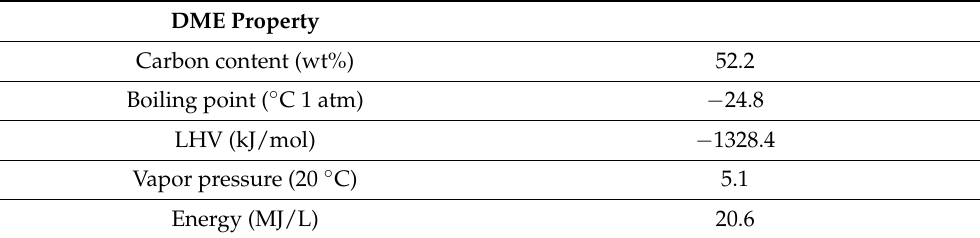
Table 1. Physicochemical properties of dimethyl